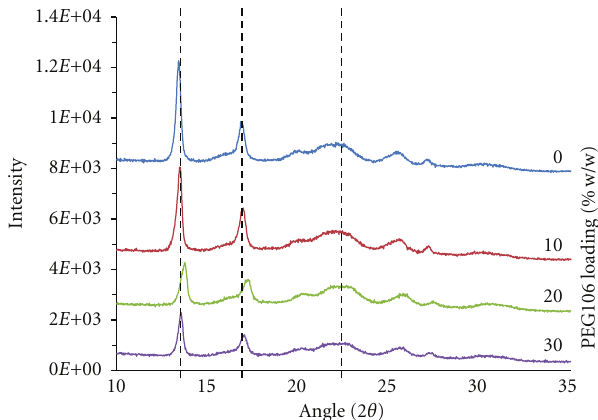
plates with films of PHB, PHB/PEG106-20, PHB/PEG106- 30, PHB/PEG2000-20, and PHB/PEG2000-30. Cells culti-